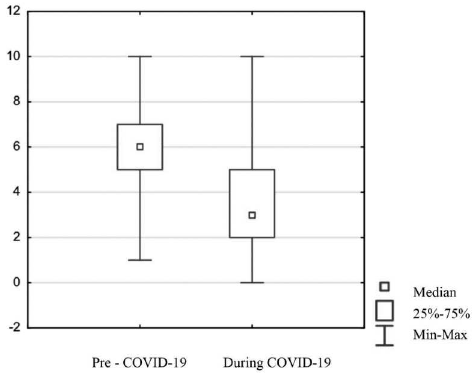
Figure 3. Comparison of scores concerning the access to health services before and during the COVID-19 pandemic among women